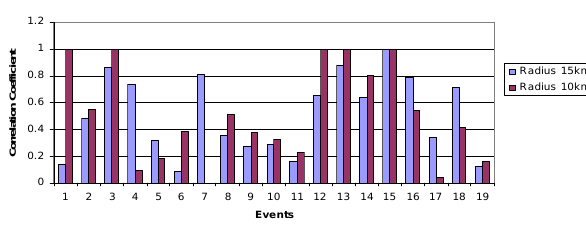
Fig. 8. The correlation coefficient for each event with a radius of 10km (in purple) and with a radius of 15km (in blue) and a time lag of 5min.